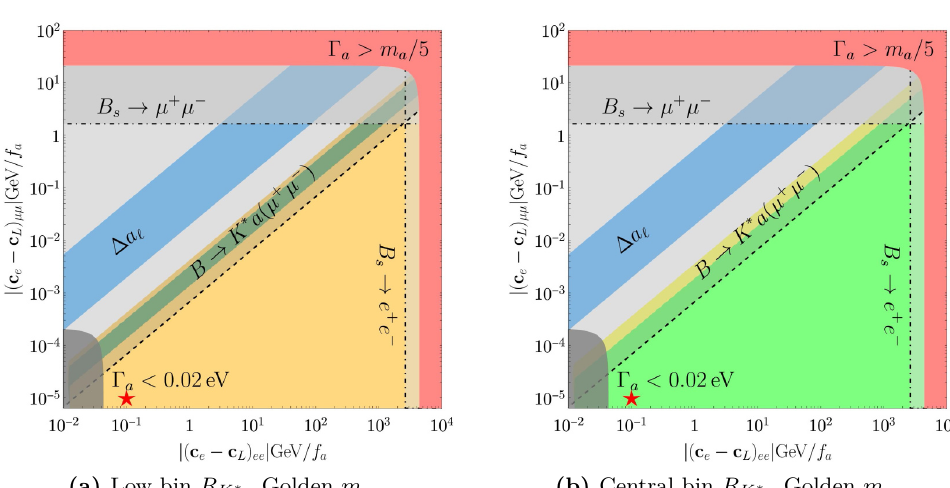
Figure 10. Parameter space | ( c e − c L ) ee | /f a vs. | ( c e − c L ) µµ | /f a interesting to explain the R K ∗ anomaly, in the low energy-bin on the left and in the central energy-bin on the right, for the golden √ mass m = 1 . 1 GeV. In green (yellow) the 1 σ ( 2 σ ) sensitivity. The ALP-quark coupling is fixed a to | ( c ) = 8 . 71 × 10 − 10 GeV − 1 . The colour code and lines follow the same description d − c Q sb | /f a as in figure